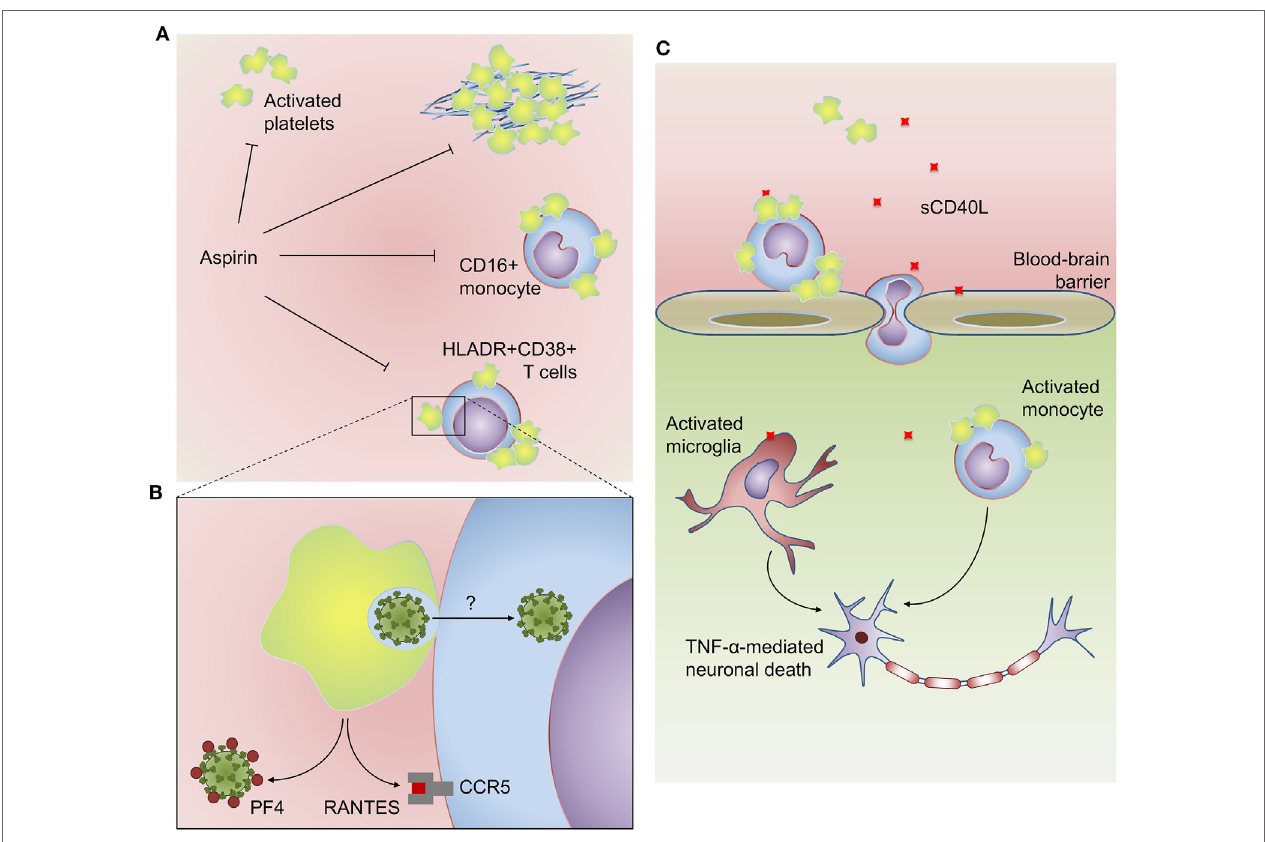
FigURe 2 | Platelets participate in inflammatory, virologic, and prothrombotic responses in HIV infection: (A) platelets from HIV-infected subjects have increased activation at baseline and hyperreactive aggregation under suboptimal prothrombotic stimuli. Activated platelets also form aggregates with CD16 + inflammatory monocytes and HLADR + CD38 + memory T cells in people living with HIV. HIV-infected subjects undertaken antiplatelet therapy with aspirin had reduced platelet activation, platelet hyperreactivity, and platelet–monocyte aggregates, as well as reduced activation of monocytes (sCD14) and T cells (HLADR + CD38 + ). (B) Platelets infected with high inoculum of reporter lentivirus are able to trans-infect susceptible T cells in vitro . Activated platelets can also inhibit human immunodeficiency virus 1 infection through the secretion of the HIV suppressive chemokines PF4/CXCL4 and RANTES/CCL5. (C) Platelet-derived CD40L plays a major role in HIV-associated neurocognitive disorders. Platelet-derived CD40L increases blood–brain barrier permeability and adhesion of GR1 + CCR2 + leukocytes on brain microvasculature. CD40L-activated platelets induce monocyte migration though brain microvascular endothelial cells, and platelet–monocyte aggregates accumulate in brain microvasculature and parenchyma. Activated monocytes and microglia are more sensitive to CD40L-induced TNF- α secretion, which contributes to neuronal apoptosis. See the text for details and